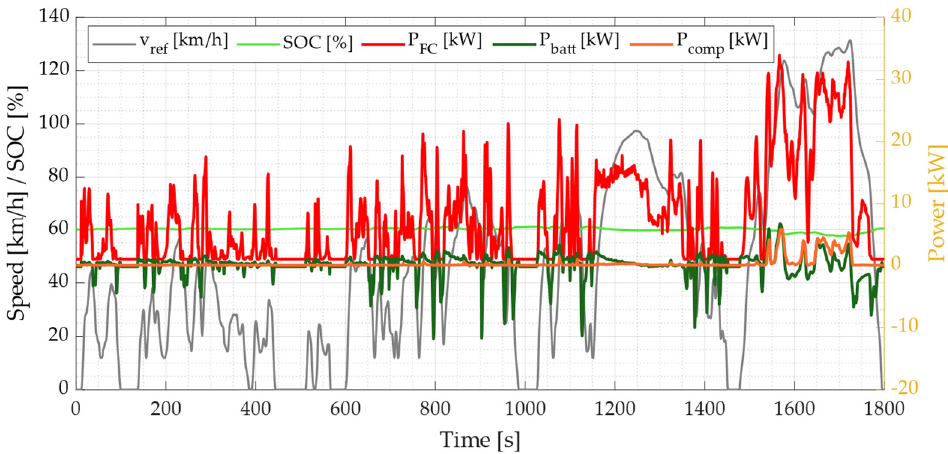
Figure 14. Simulation conducted on WLTP driving cycle with fuzzy logic control strategy.